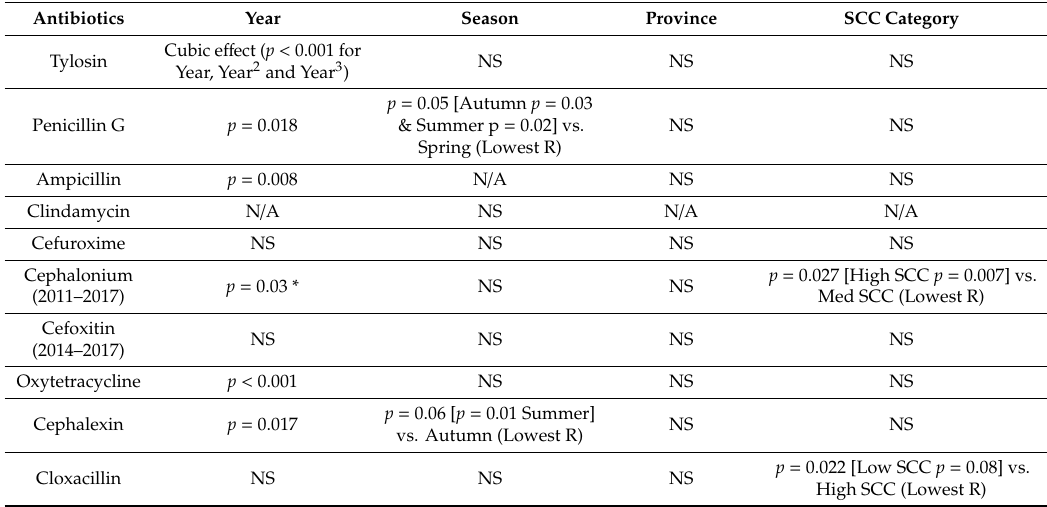
Table 2 . The minimum inhibitory concentrations (MIC) 90 and MIC 50 for maltose-positive and maltose-negative S.